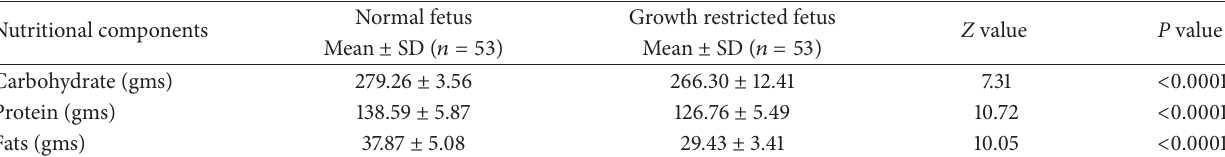
Table 3: The comparison of maternal nutritional status in study groups.